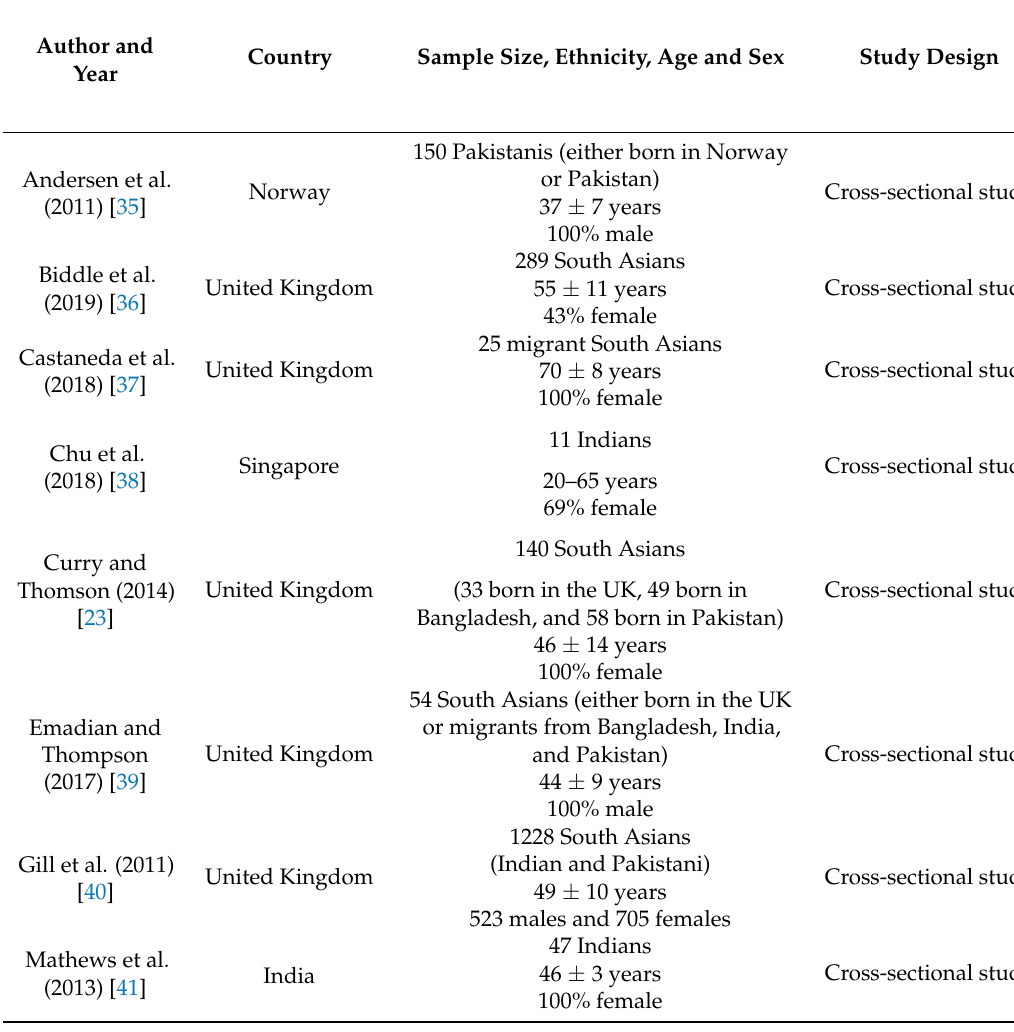
Table 2. Overview of study characteristics.